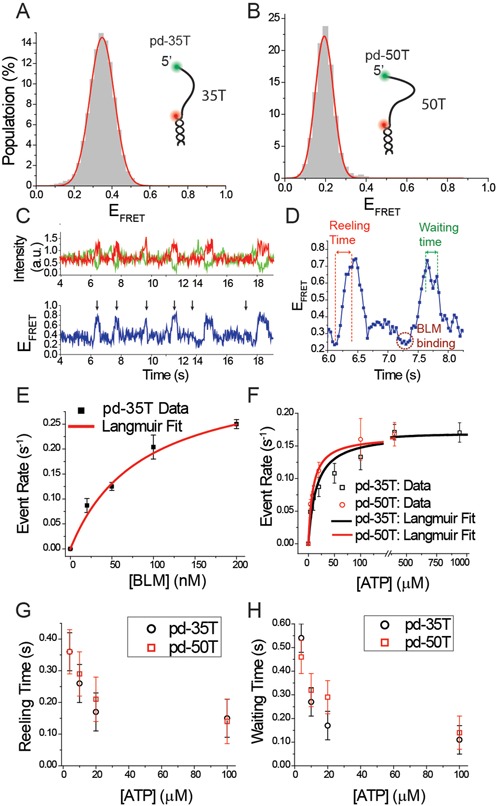
(A) smFRET histogram of pd-35T construct at 150 mM K+. The inset shows a schematic of this construct. (B) smFRET histogram of pd-50T construct at 150 mM K+. The inset shows a schematic of this construct. (C) A representative smFRET trace showing reeling activity for pd-35T construct. Individual reeling events are marked by black arrows. (D) Zoomed-in portion of (C) between times 6.0 s and 8.5 s in which reeling time and waiting time along with BLM binding (initial FRET dip before FRET increase) are identified. (E) Reeling event rate as a function of BLM concentration at 20 μM ATP for pd-35T. (F) Reeling event rate as a function of ATP concentration at 20 nM BLM for pd-35T (black rectangles) and pd-50T (red circles). The curves in (E) and (F) are Langmuir binding isotherm fits to the data. The error bars for the event rates in (E) and (F) are determined by dividing the complete data set into three and finding the standard deviation of the mean values of these three data sets. (G) Reeling time as a function of ATP at 20 nM BLM for pd-35T (black circles) and pd-50T (red rectangles). (H) Waiting time as a function of ATP at 20 nM BLM for pd-35T (black circles) and pd-50T (red rectangles). The error bars in (G) and (H) originate from the uncertainty in determining the beginning and end of the reeling time and waiting time, respectively.